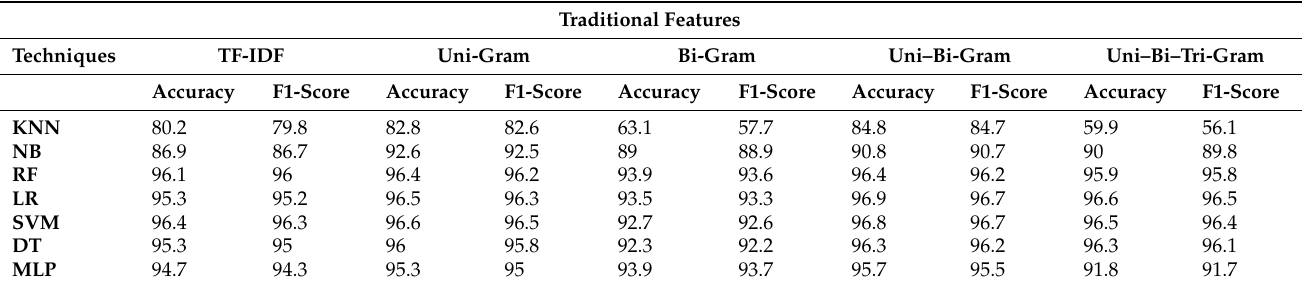
Table 8. Machine learning classifiers applied on modified labeled